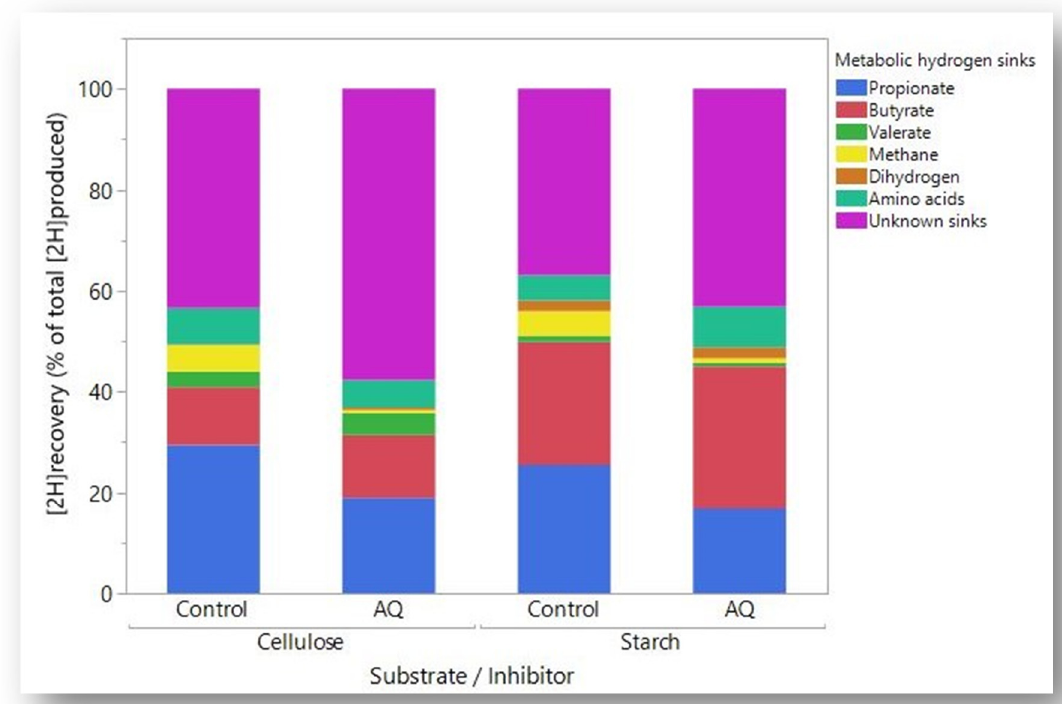
Figure 3. Partial recoveries of metabolic hydrogen (ratio of metabolic hydrogen incorporated into each sink to total metabolic hydrogen produced, expressed as percentage) in mixed rumen batch cultures growing on cellulose or starch with functional methanogenesis (Control) or with methanogenesis inhibited by 9, 10-Anthraquinone (AQ).